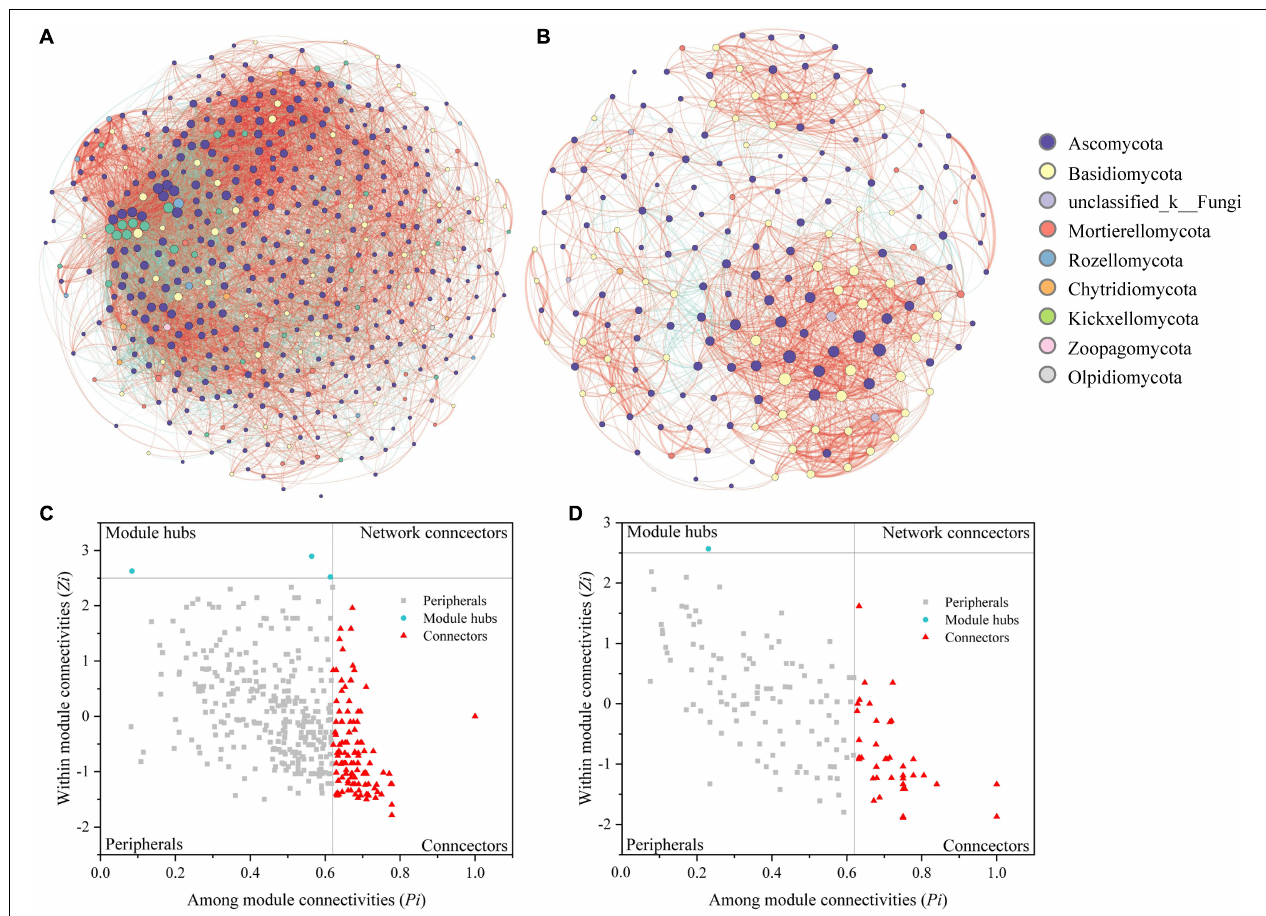
FIGURE 4 | Networks of fungal communities in the rhizosphere soil (A) and root endospheres (B) . Node color represents fungal phylum of the OTUs. Node size is proportional to degree connections of the OTUs. Red edges indicate positive relationships, and green edges indicate negative relationships. Zi-Pi plots showing distribution of OTUs based on their topological roles in the rhizosphere soil (C) and root endospheres (D) networks. Threshold values of Zi and Pi for categorizing OTUs were 2.5 and 0.62,